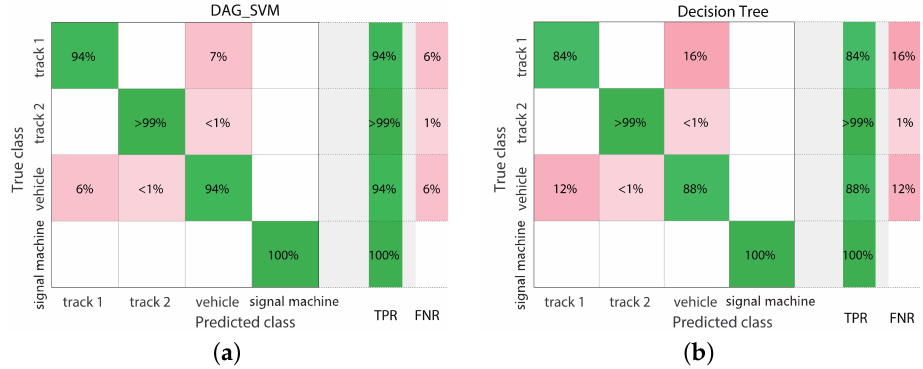
Figure 9. Confusion matrix of track recognition by DAG-SVM and decision tree at a radar height of